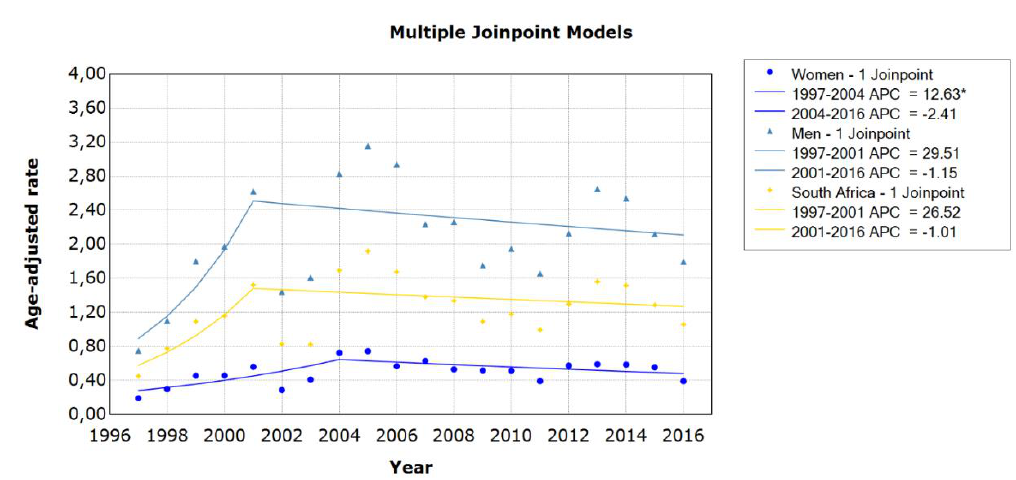
Figure 2. Trends in age-standardised suicide mortality rates in men and women in South Africa using joinpoint regression analysis. Data markers represent observed rates; lines represent joinpoint regression using one joinpoint; APC = annual percentage change; * indicates that the APC is significantly different from zero at the alpha = 0.05 level.